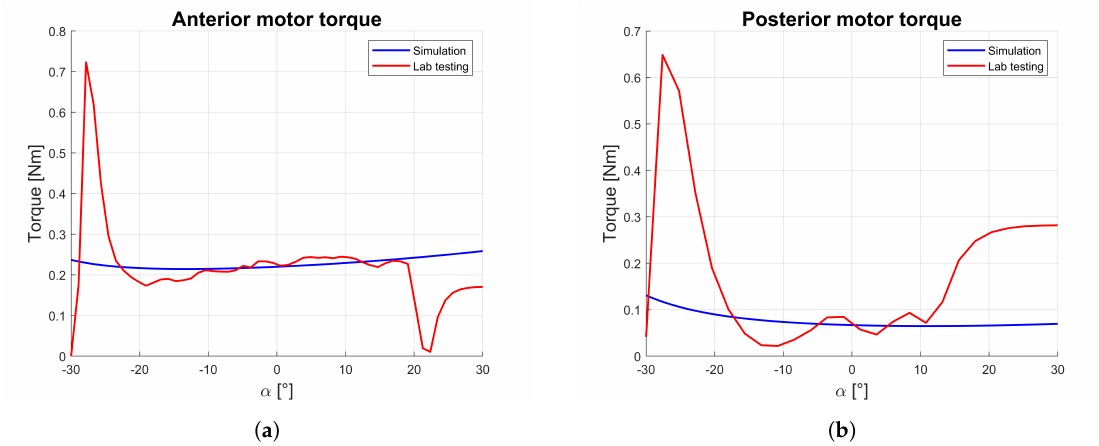
Figure 11. Comparison between results from simulation and lab testing in terms of motor torque during: ( a ) flexion motion; ( b ) extension